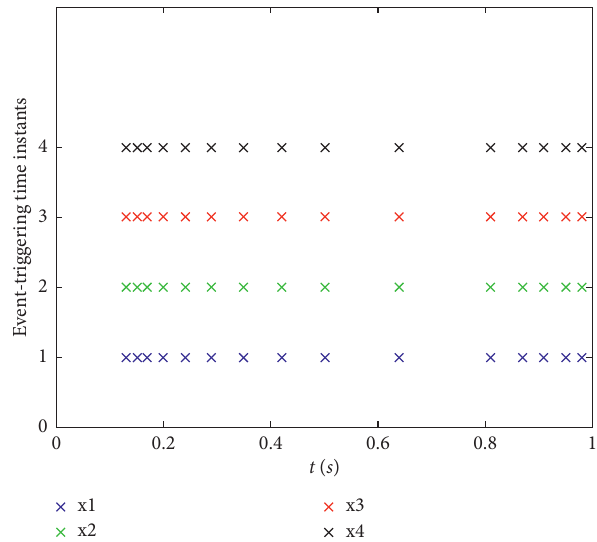
Figure 7: The 2nd state error trajectory of each agent under protocol